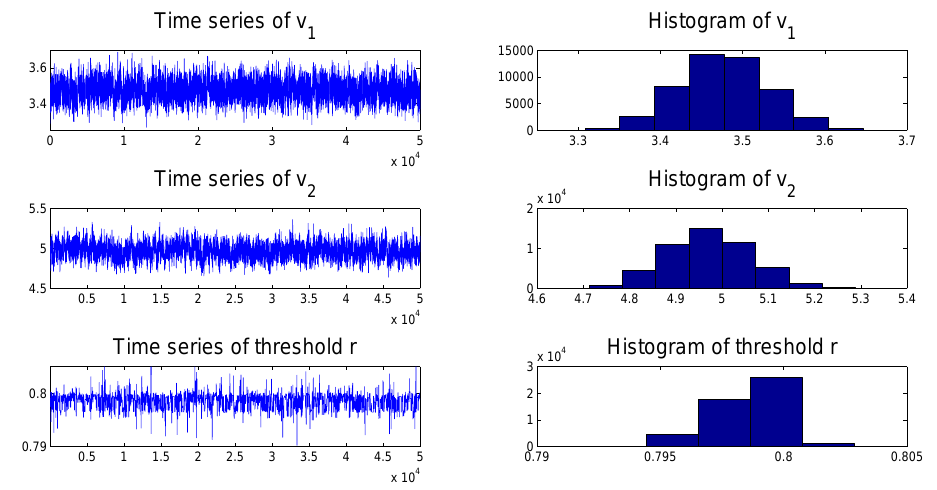
Figure 3. Time series and histograms of the samples drawn from the full conditionals of the parameters in the Weibull component distributions of the TSCD model and the full conditional of threshold based on simulated duration